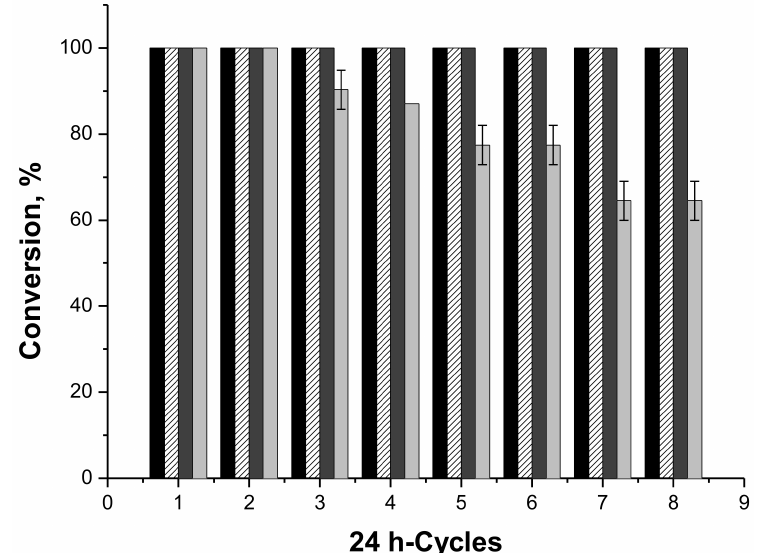
Figure 1. Reaction conversions as function of the number of cycles of butyl butyrate synthesis at 37 ◦ C for 24 h cycles, using 0.1 M in heptane for acids and alcohols, and 200 U/g of acid (esterification activity) and 20 g/L molecular sieves for all biocatalysts. IMMTLL-T2-150 (dark gray column), IMMAPF-T2-150 (gray column), IMMCALB-T2-350 (black column), PFL-octyl-silica (hatched column)-100% was the conversions of the first reaction cycle. All assays were performed in duplicate and the standard deviations were very closed to zero, with only a few closed to